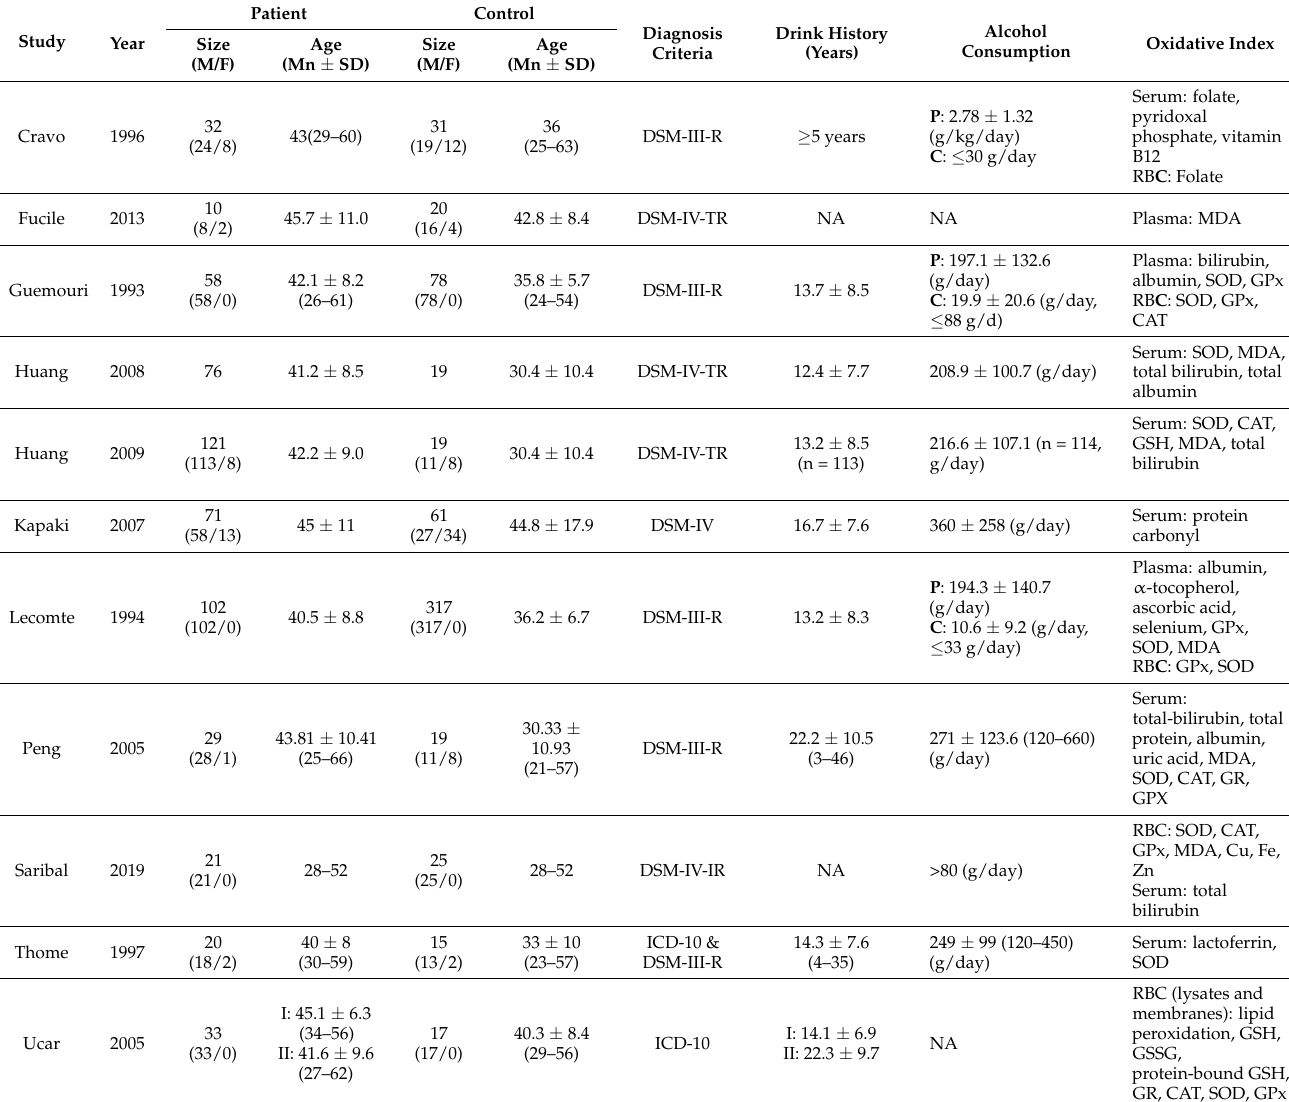
RBC (lysates and membranes): lipid peroxidation, GSH, GSSG, protein-bound GSH, GR, CAT, SOD,